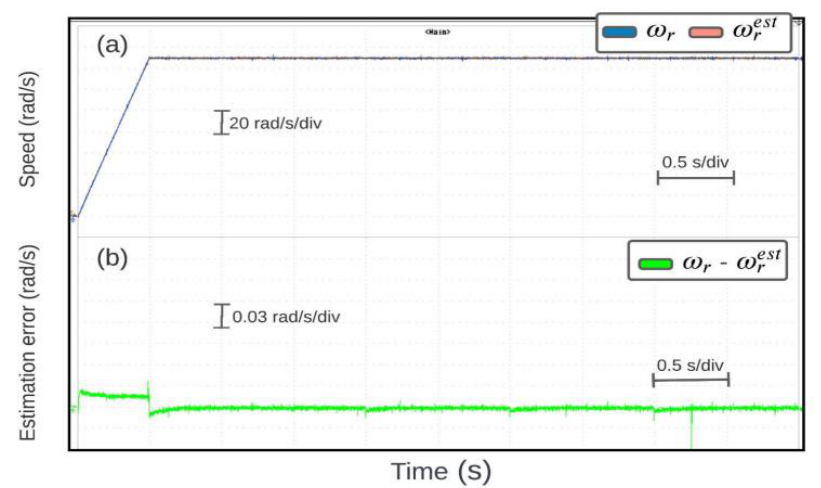
Figure 5. OeW-5PIM performance under load torque variations ( a ) speeds responses; ( b ) estimation error.